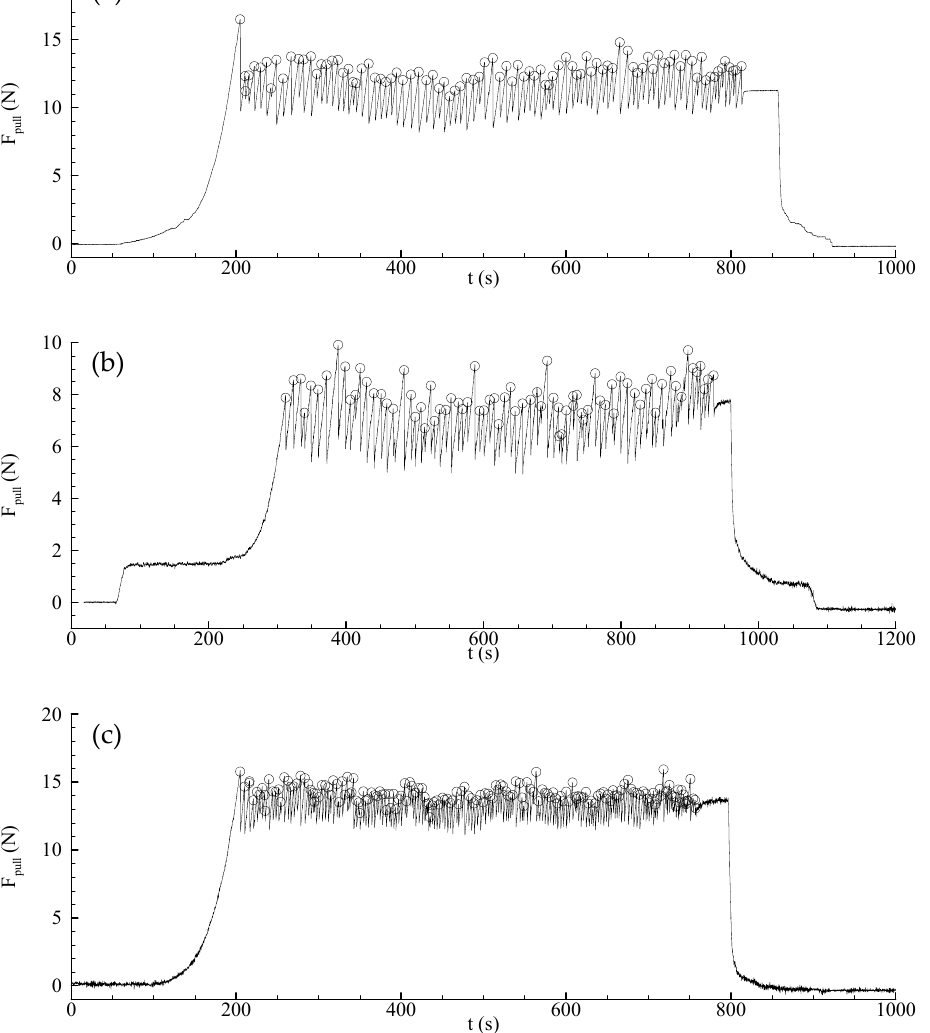
Figure 5. The load cell reading in test 1. Pulling the ACM in ( a ) still water, ( b ) 𝑈 = 1.0 m/s and ( c ) 𝑈 = − 1.0 m/s.